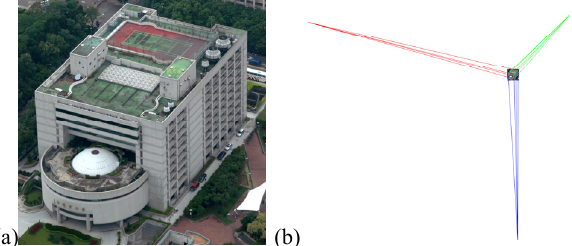
Table 3: Validations of SOR structure parameters.